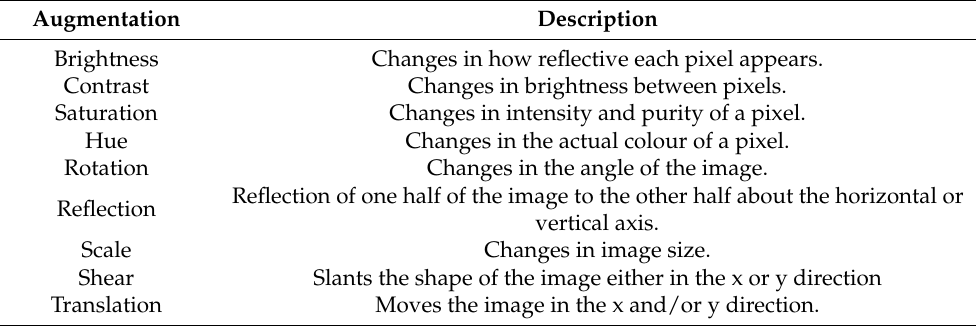
Figure 2. Example of a raw image captured ( a ), and the resulting 1024 × 1024 tiles with 50% overlap between consecutive rows and columns ( b ). Table 1. A list of image augmentations applied to the dataset and their